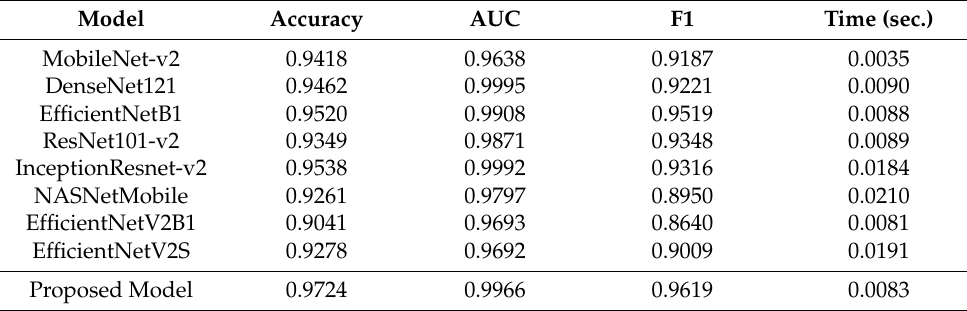
Table 11. Performance metrics of ensemble models for binary